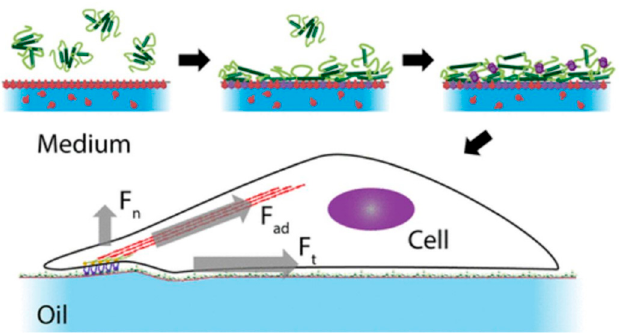
Figure 2. Schematic figure of a cell applying forces across an oil–water interface in the normal and tangential directions. Cell spreading and proliferation are enabled by the protein nanosheets [36]. Forces are presumed to be transmitted from the cell cytoskeleton to the protein nanosheets (extracellular environment) through focal adhesion proteins, and the forces exerted by cells are thought to be counterbalanced by the strength of the protein nanosheets. Reproduced from [8] with permission from American Chemical Society, 2018.